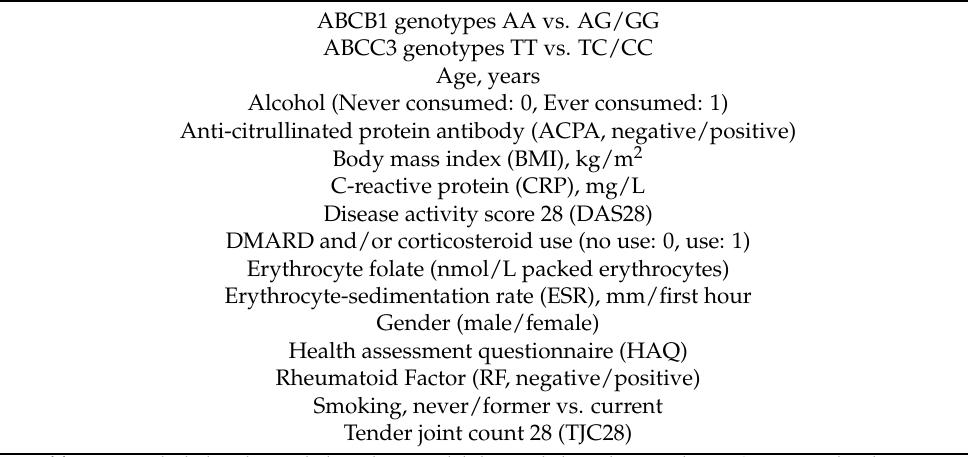
Table 1. List of baseline features that were included in the study.